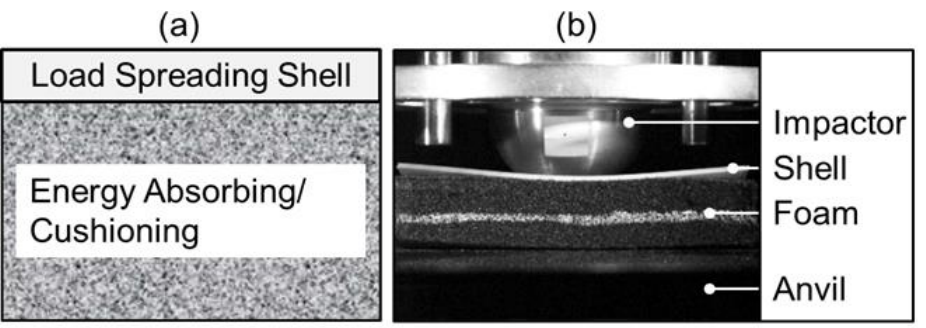
Figure 2. ( a ) Schematic of a typical piece of Personal Protective Equipment containing pressure dissipating material (hard outer shell) and energy absorbing/cushioning material (deformable foam); ( b ) Impact adapted from British Standard